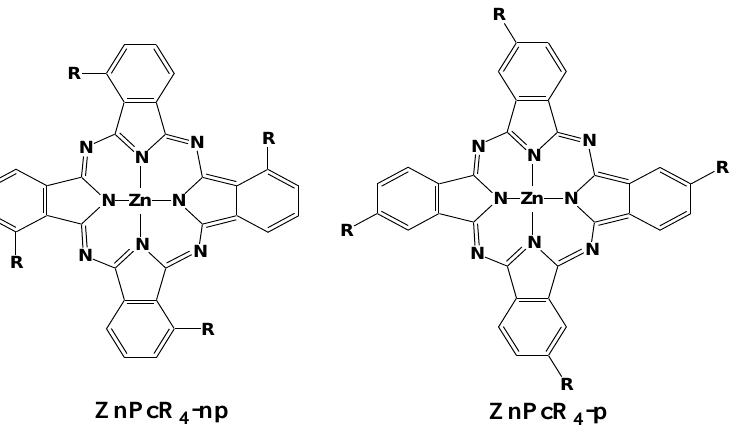
Figure 1. Structure of tetrahalogensubstituted zinc phthalocyanines bearing F or Cl-substituents in non-peripheral (ZnPcF 4 -np) and peripheral (ZnPcF 4 -p) positions (R = F or Cl).